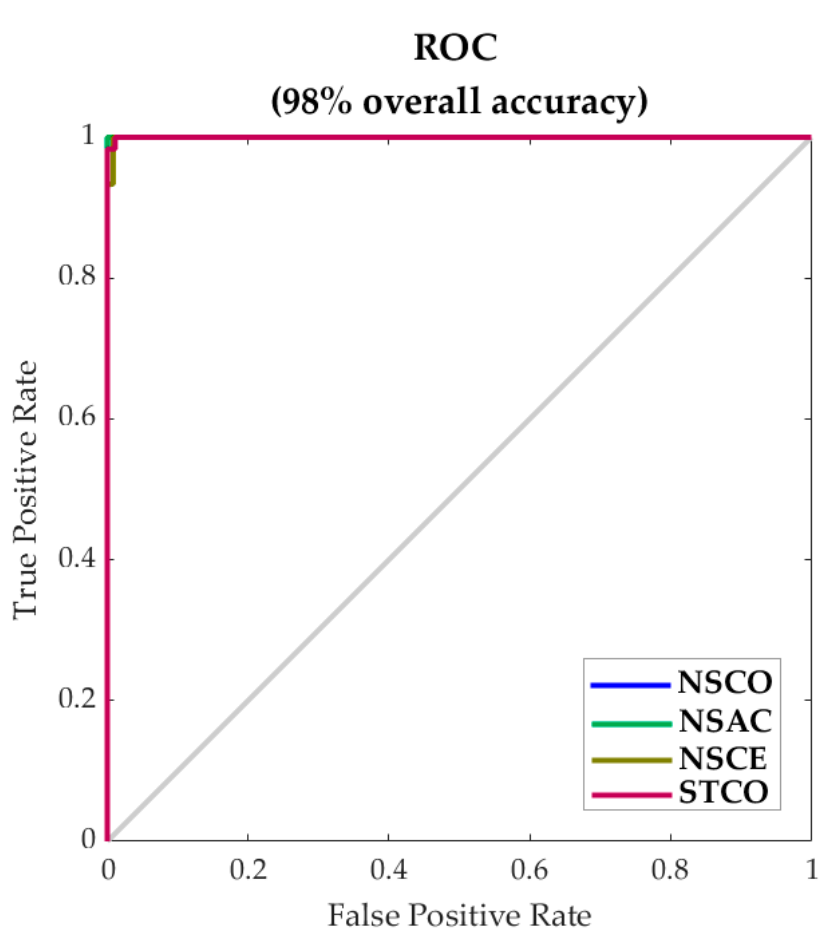
Figure 5. Receiver operating characteristic (ROC) curve for the machine learning model developed. Abbreviations: NSAC = non-smoke-tainted wine with activated carbon treatment, NSCE = non- smoke-tainted wine with enzyme and activated carbon treatment, NSCO = control non-smoke-tainted wine and STCO = control smoke-tainted wine.